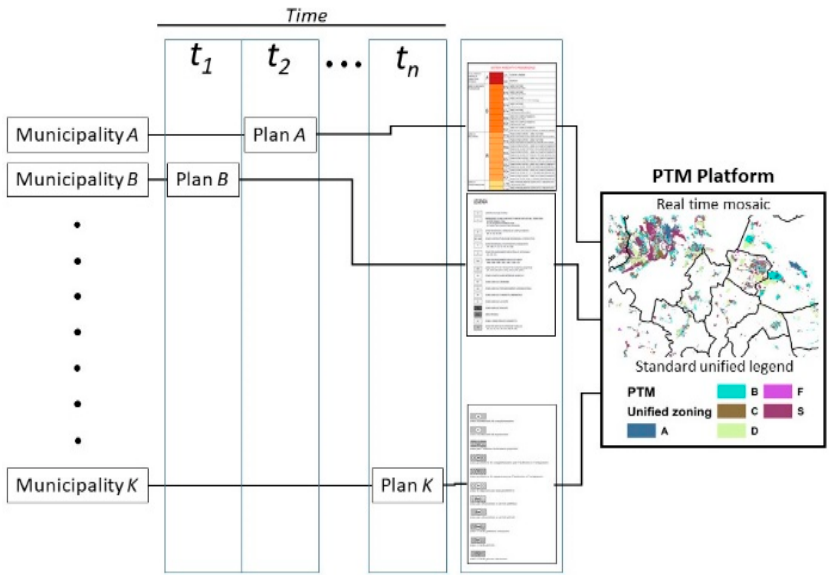
Figure 9. PTM technical procedure platform. In this figure, the field of the “custom legend” shows only the symbolic configurations of the typical legends of Italian plans.